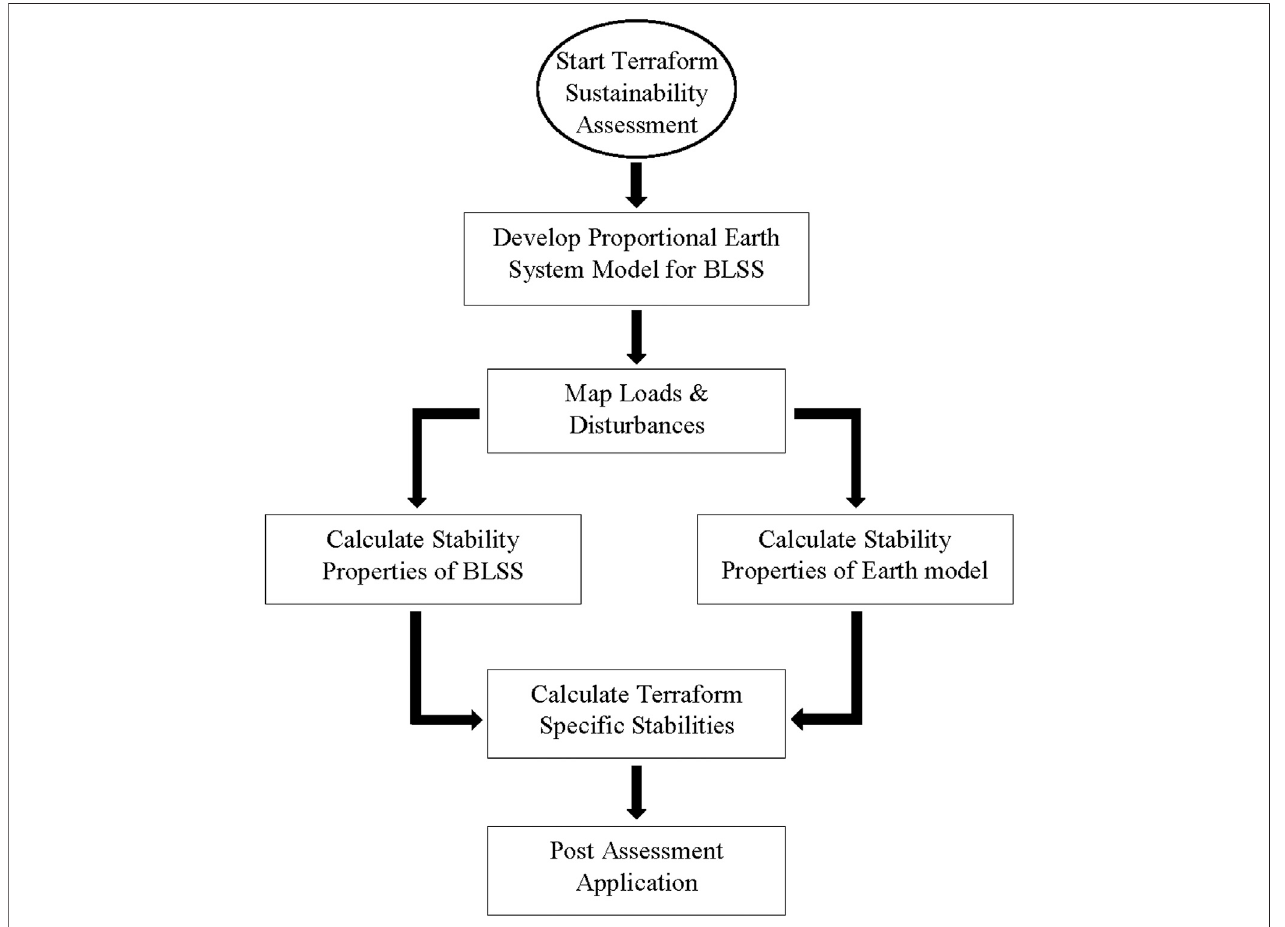
FIGURE 2 | Proposed Terraform Sustainability Assessment Framework process fl